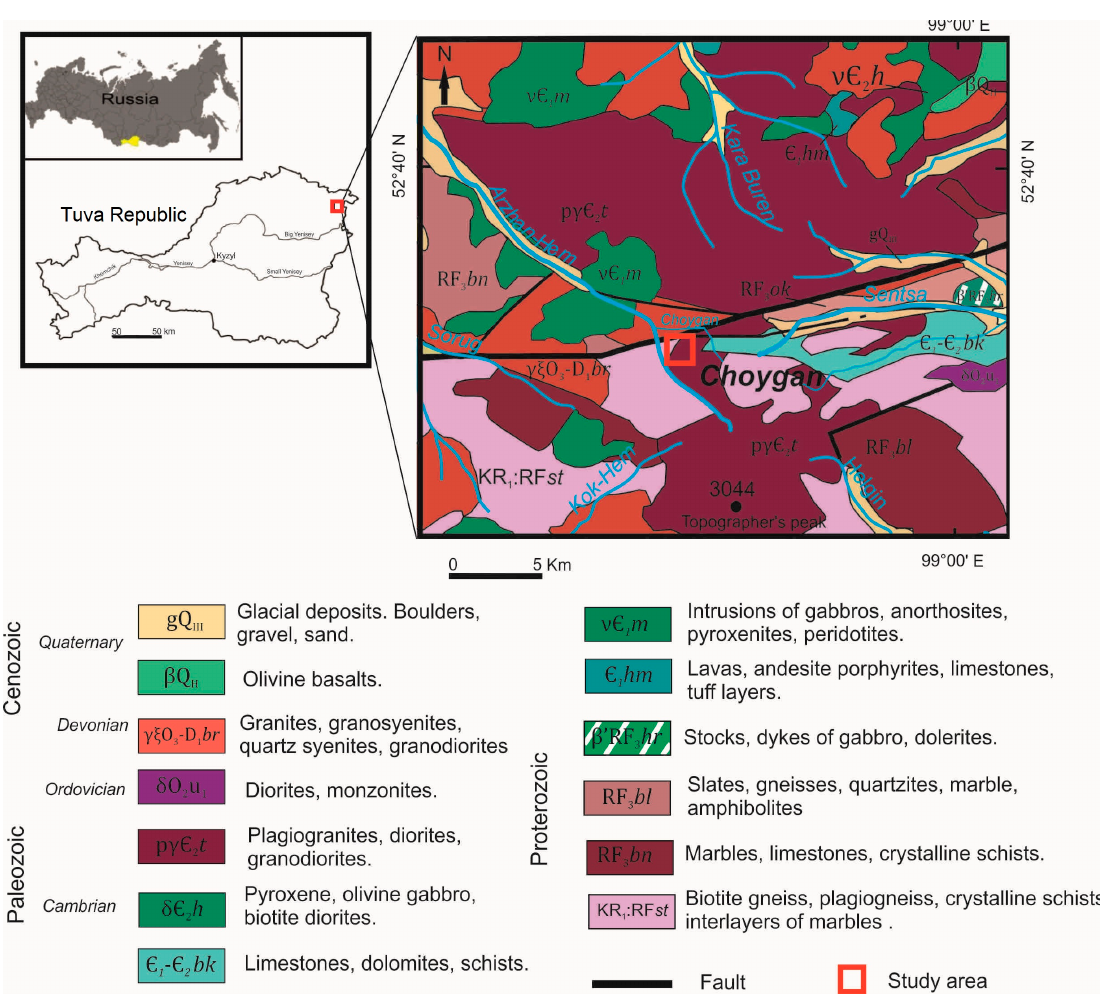
Figure 1. Location and geological setting of the study area (the square indicates the sampling field; for the sampling point locations, see Figure 2) [35].